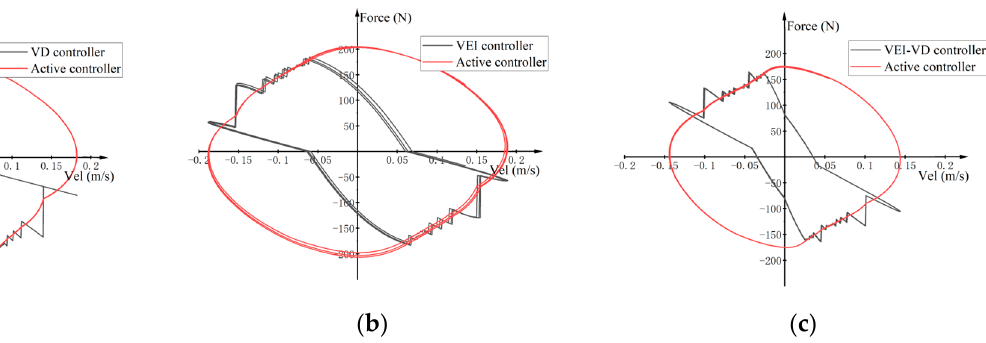
Figure 15. Available force-velocity areas of actuators: ( a ) VD device; ( b ) VEI device; ( c ) VEI–VD device.